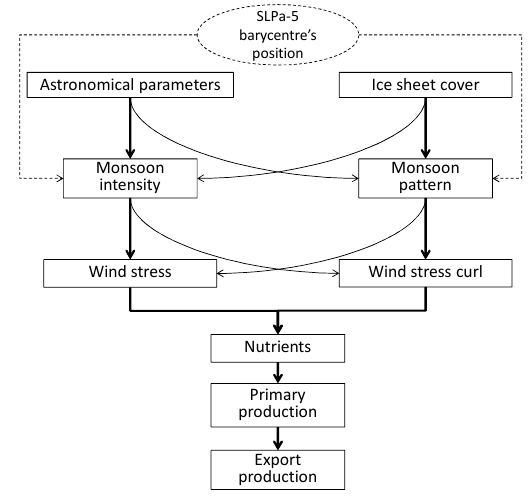
Figure 14. Identified seasonal (JJAS) processes behind productivity changes in glacial and interglacial climates. Bold lines highlight the major